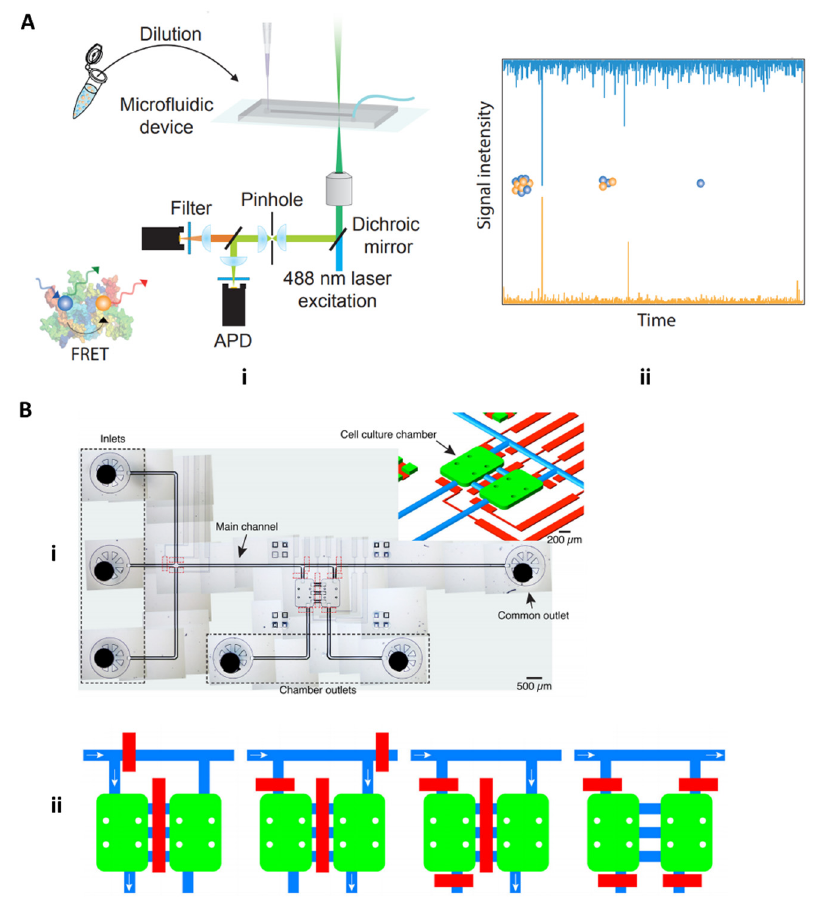
Figure 10. Parkinson’s disease microfluidic devices. ( A ) Horrocks 2015 microfluidic device for detecting amorphous, less cytotoxic aSyn monomers and oligomers and highly cytotoxic oligo- mers with FRET (adapted with permission from Horrocks et al. 2015 under copyright 2015 Ameri- can Chemical Society). ( B ) Fernandes 2016 cell culture microfluidic device with pneumatic channel